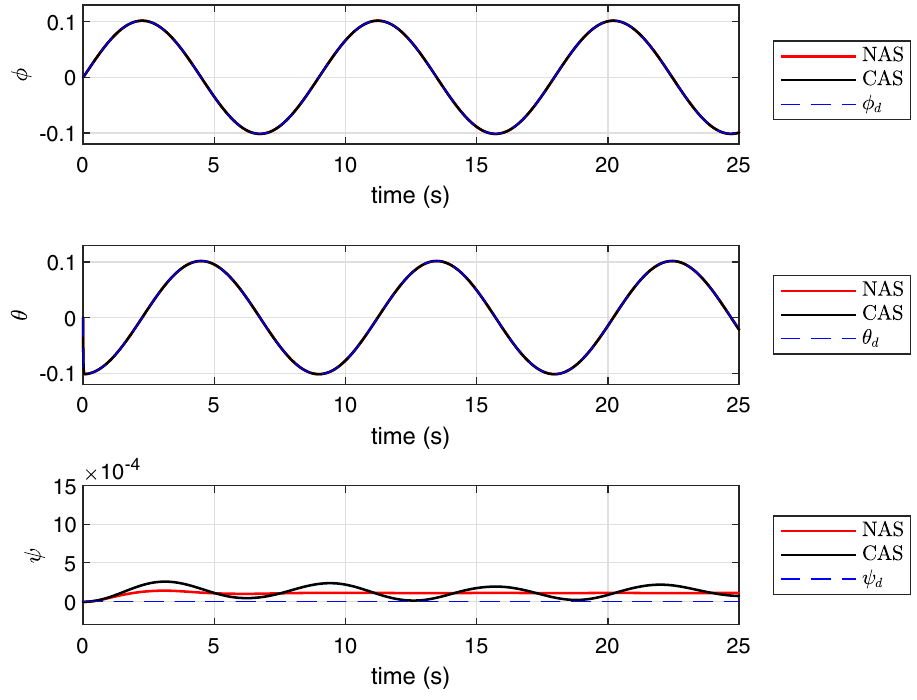
Figure 6. The profile of φ , θ and ψ .